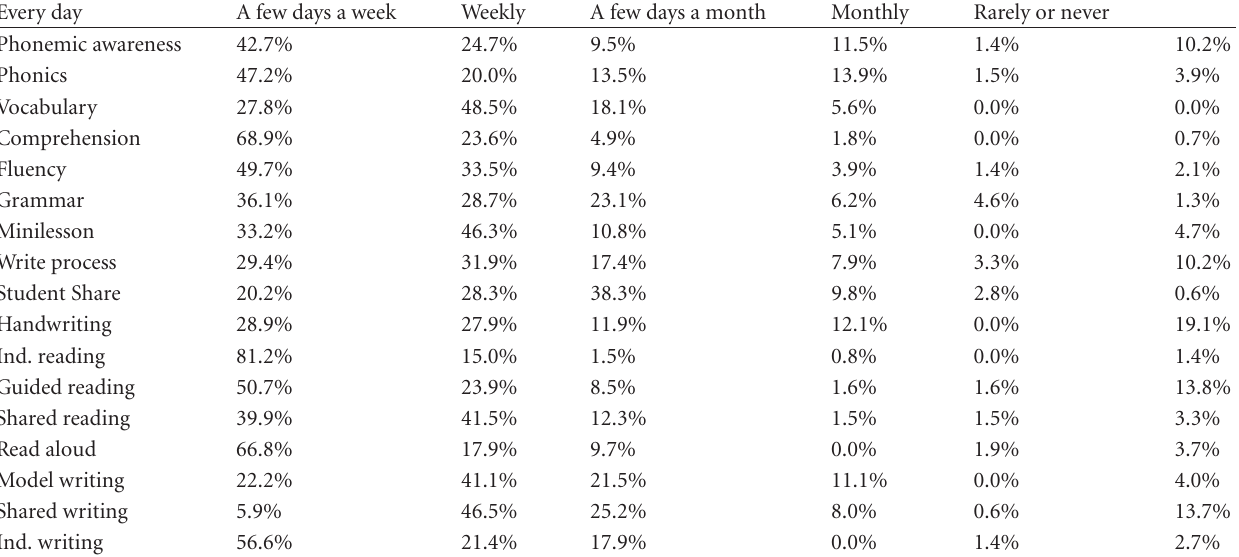
Table 4: Teachers’ self-reported